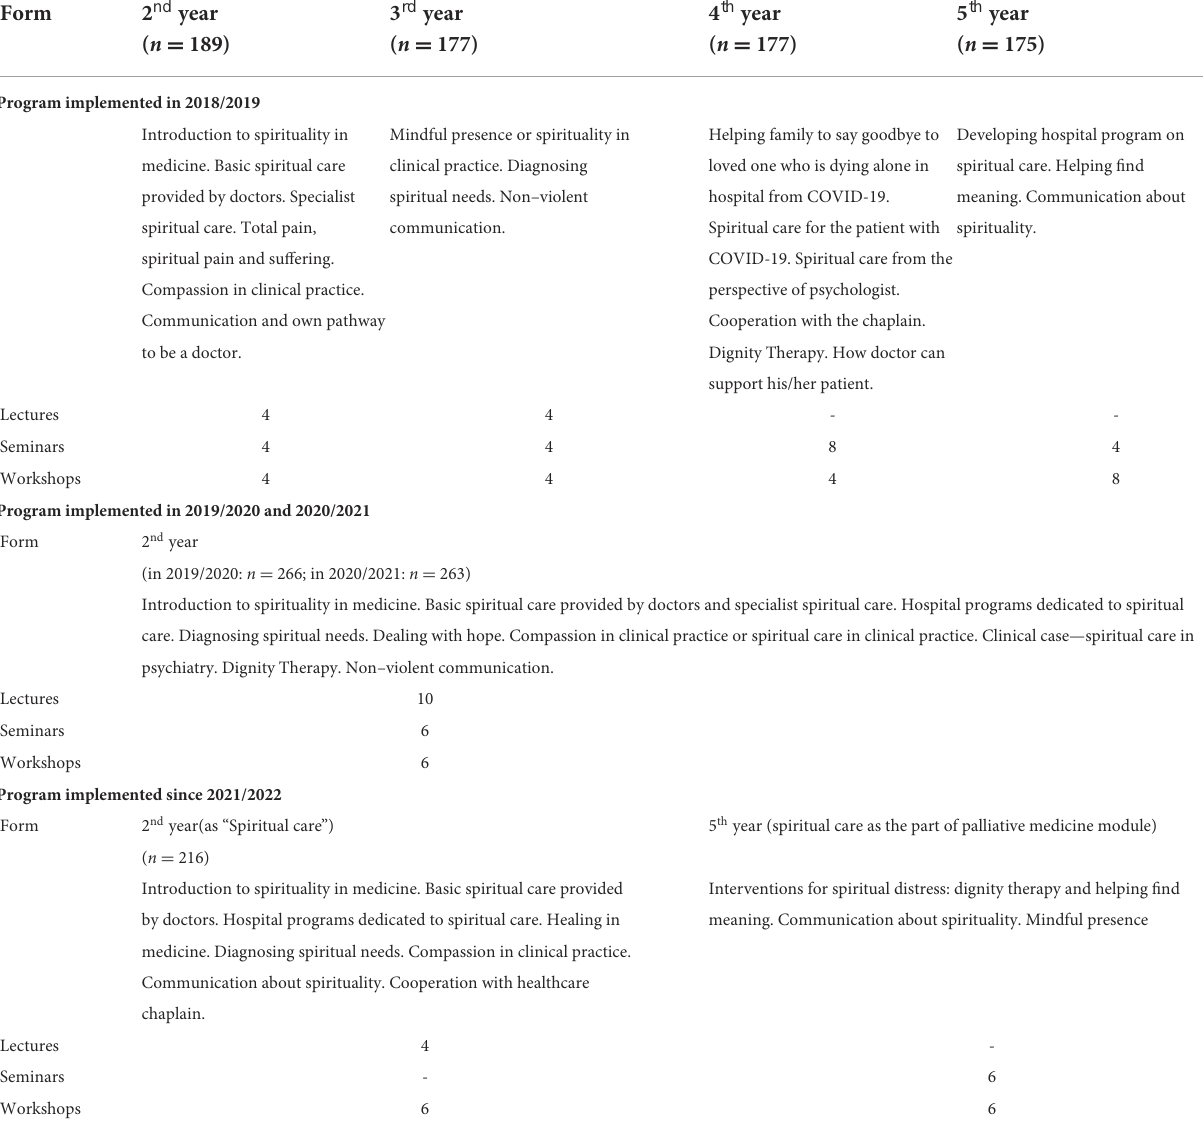
TABLE 1 An outline of the obligatory programme of education in spirituality for medical students at the Collegium Medicum in Bydgoszcz, Nicolaus Copernicus University in Toru´n.